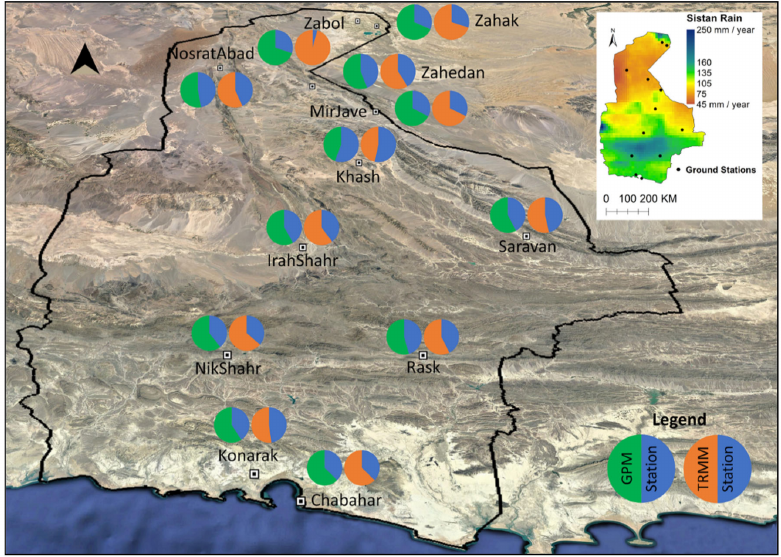
Figure 8. Precipitation correction coefficient for Sistan-Baluchestan. The legend is shown when satellite and station have an equal amount. The image is tilted to create a 3D